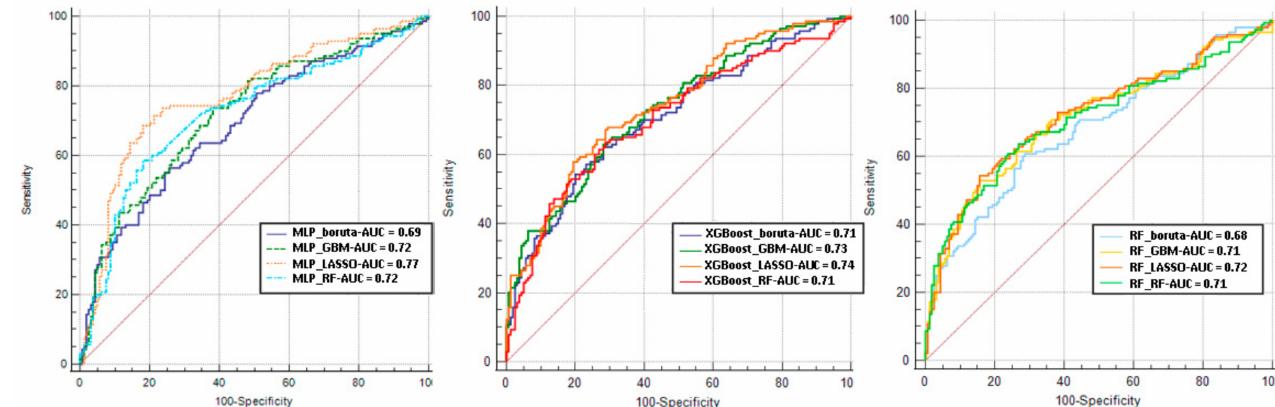
Figure 3. Evaluation of mortality prediction for different machine learning (ML) models. Receiver operating characteristic curve from ten-fold cross-validation for mortality prediction. AUC, area under the curve; MLP, multilayer perceptron; GBM, gradient boosting machine; XGBoost, extreme gradient boosting; RF, random forest; LASSO, least absolute shrinkage and selection operator.